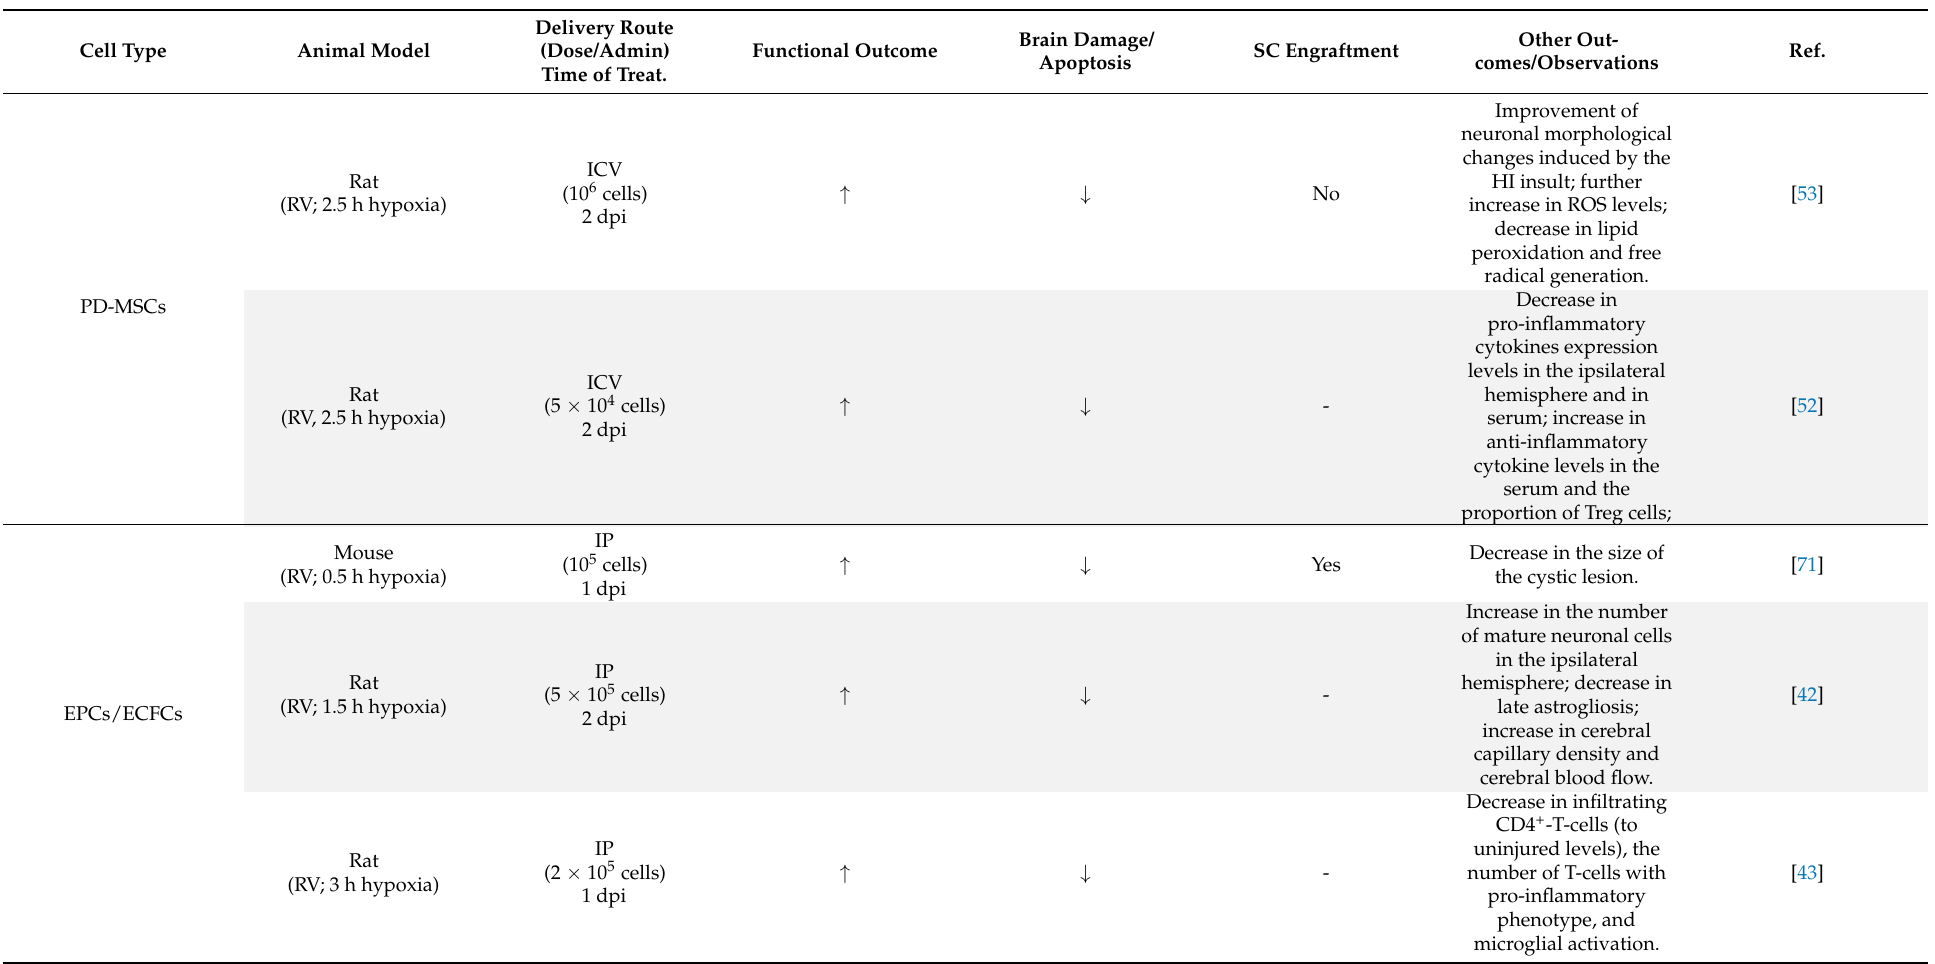
Table 2. Studies focusing on the therapeutic potential of placenta-derived mesenchymal stem/stromal cells and endothelial progenitor cells/endothelial colony-forming cells from human origin in animal models of hypoxic-ischemic